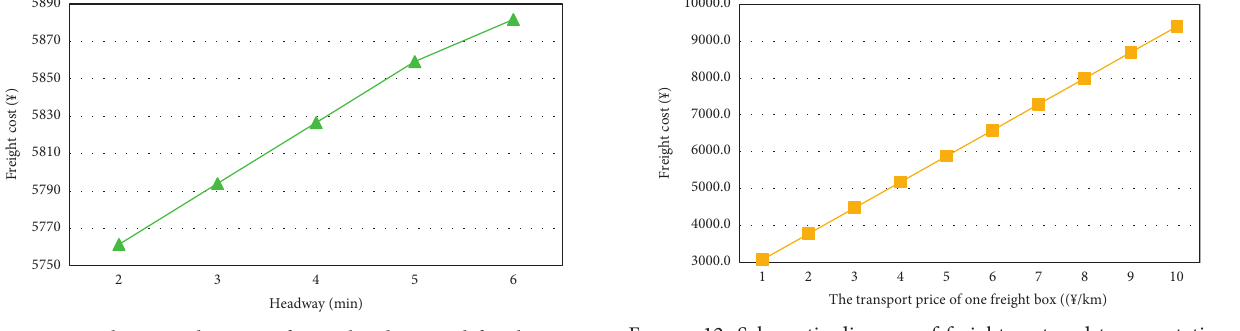
Figure 11: Schematic diagram of train headway and freight cost. Figure 12: Schematic diagram of freight cost and transportation cost of per cargo box.